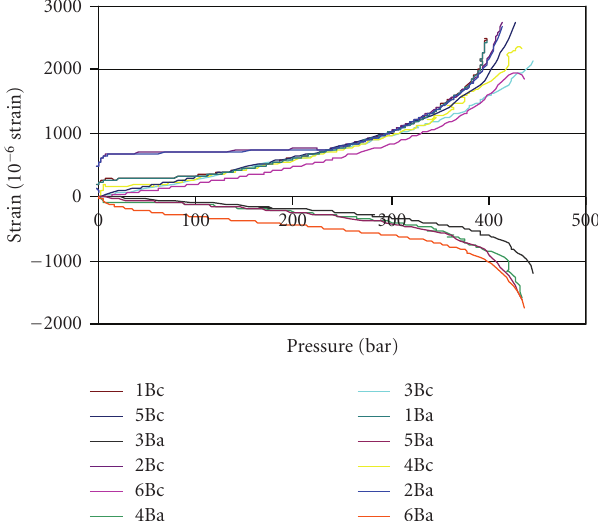
Figure 10: Diagrams of strain versus pressure for B